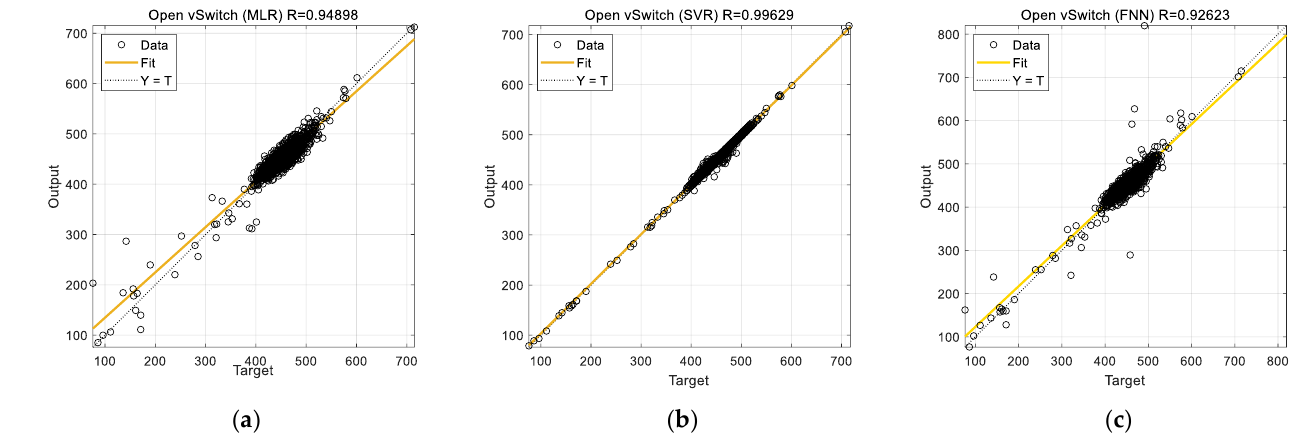
( c ) Figure 7. Firewall regression plot: ( a ) MLR; ( b ) SVR; and ( c ) FNN. Figure 8 shows the regression plots for the Open vSwitch VNF. The SVR model pro-